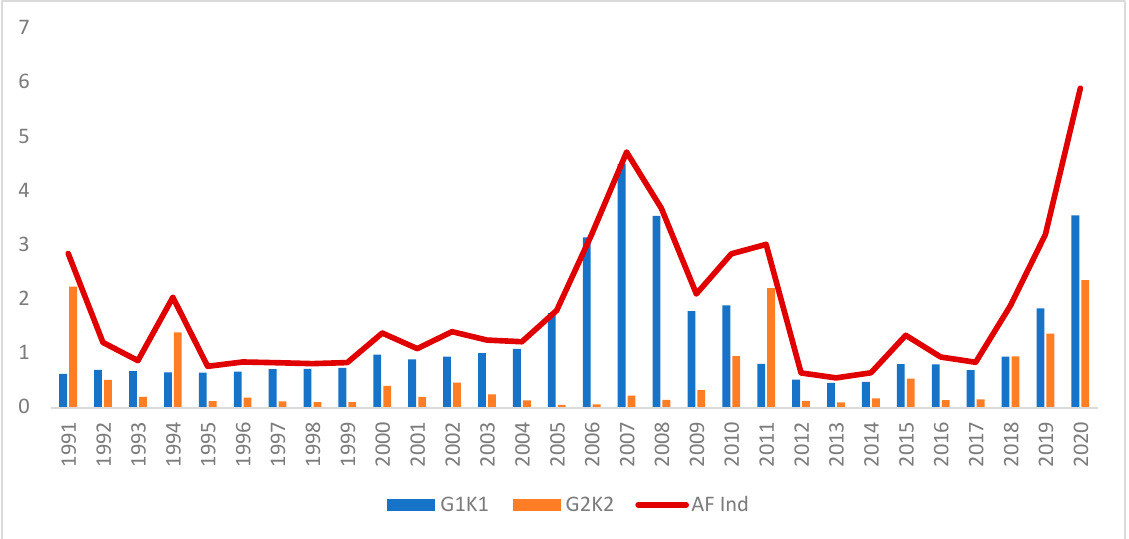
Figure 5. Affordability index and sub-indices.